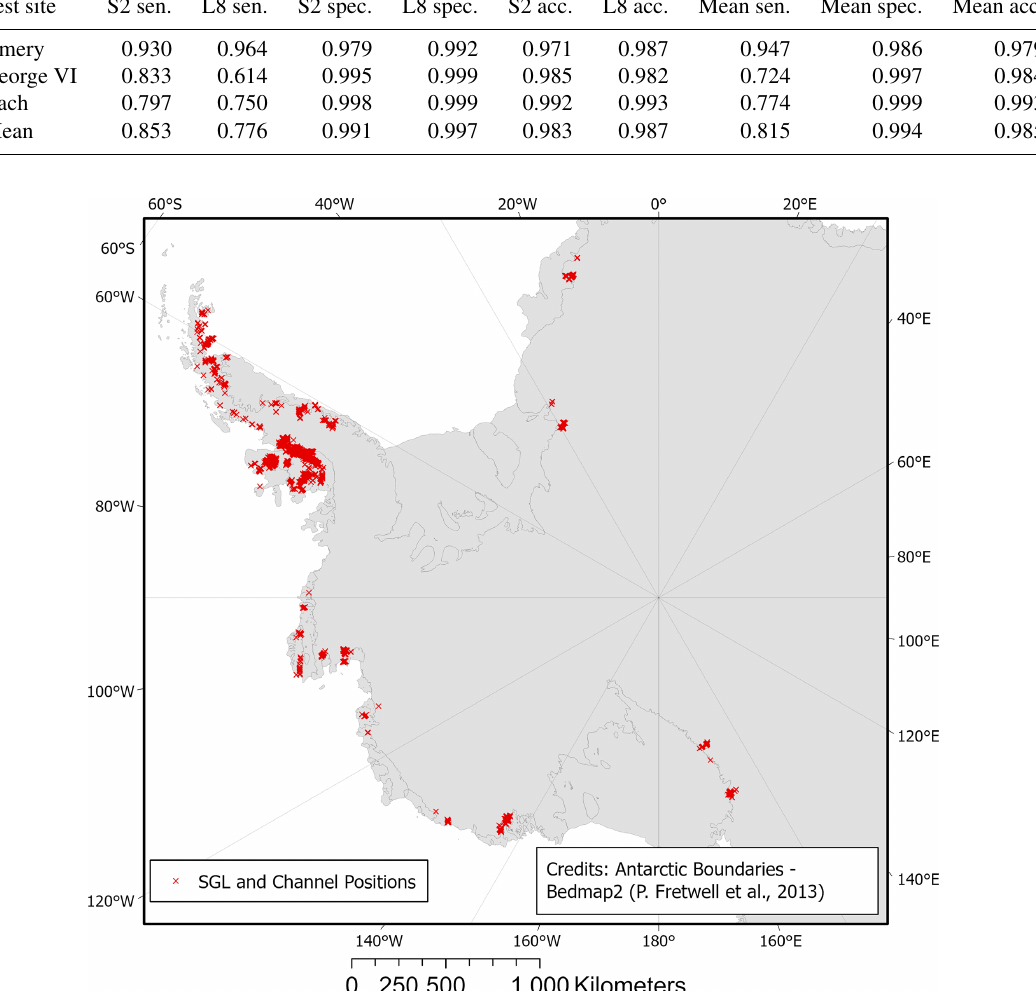
Figure 4. Location of the 10478 SGLs and channels on the WAIS and AP represented by the red crosses as mapped in S2 and L8 imagery from January and February 2017. Antarctic boundaries are according to Bedmap2 (Fretwell et al.,